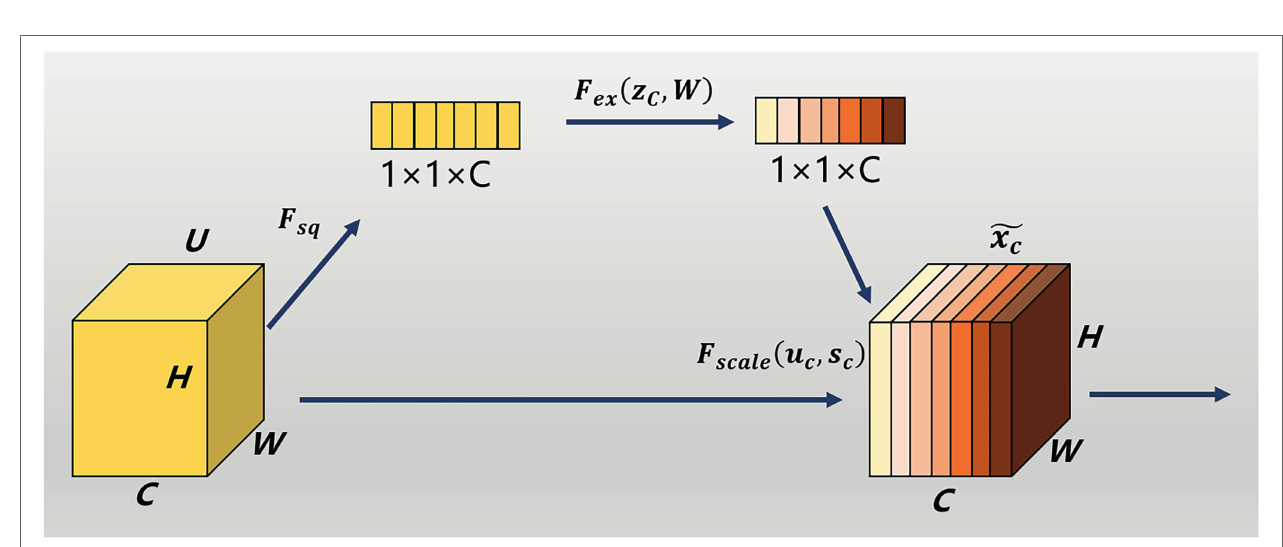
FIGURE 7 | A squeeze-and-excitation